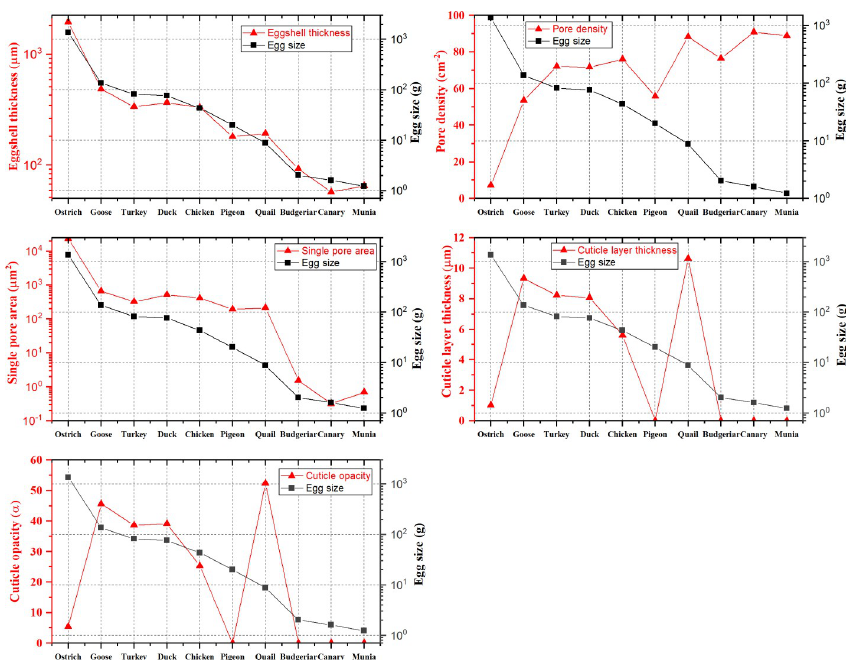
Fig 5. Variation of eggshell traits as a function of egg size. As egg weight, eggshell thickness, and pore area showed great variation among the eggs of the ten bird species, those traits are shown on a logarithmic scale. The egg size was determined by egg weight according to the results in Table 1. The egg weight decreases from ostrich to canary. Eggshell thickness and pore area decrease with egg size. Cuticle opacity, and cuticle layer thickness do no display a significant trend with egg